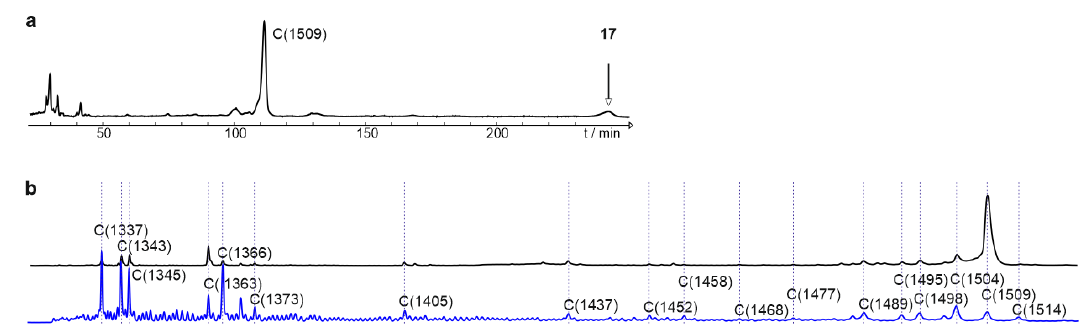
Figure 6. Cleavage of dye-labeled 430-mer 17 (250 nM) by conjugate 12 (1 µM), analyzed with an ALFexpress sequencer (50 mM Tris buffer (pH 8.0), 37 °C). ( a ) Overview: The peak of 430-mer 17 appeared at 242 min, a main cleavage fragment at 111 min (8% denaturing PAGE). ( b ) Analysis of the first 200 nt at higher resolution. Black line: RNA 17 after incubation with conjugate 12 . Blue line: Base ladder of RNA 17 . The minor peaks correspond to CA dinucleotide sites, known to be highly susceptible to hydrolysis. In the present experiment, this effect was helpful for the assignment of peaks (10% denaturing PAGE). Dotted lines were included to mark corresponding peaks in both electropherograms.